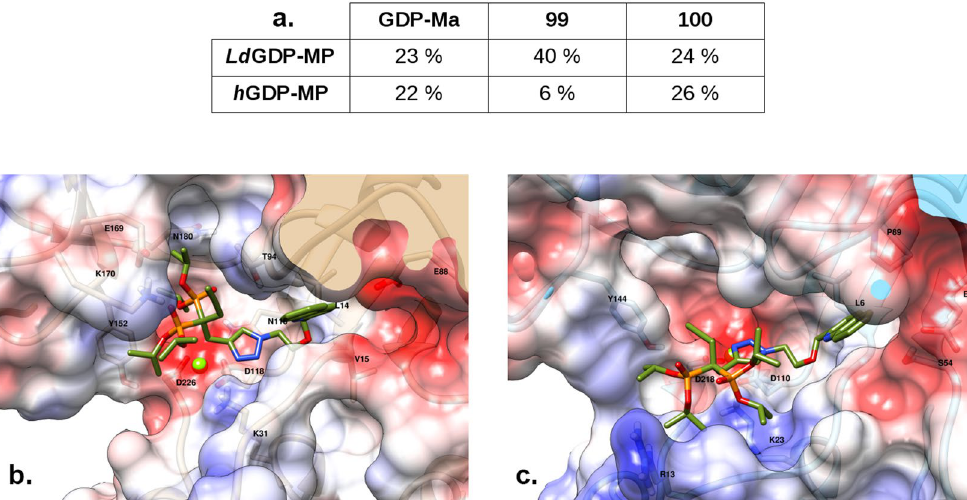
Figure 6. Docking analysis of compounds 99 and 100 on Ld GDP-MP and h GDP-MP. ( a ) Percentage of “good” poses of GDP-Mannose, compound 99 and 100 over the hundred conformations generated by the ten docking calculations onto Ld GDP-MP and h GDP-MP. For GDP-Mannose, a “good” pose is the one observed in the PDB crystallographic structure 2X5Z. For the two compounds 99 and 100 , a “good” pose has the quinoline group located on the GDP-Mannose guanine. ( b,c ) Position and orientation of the lowest energy “good” pose of compound 99 in the catalytic site of Ld GDP-MP ( b ) and hGDP-MP ( c ). The protein surface is colored as a function of the charge density (red, white and blue colors indicating negative, neutral and positive area, respectively). The amino-acids that make contacts with compound 99 are indicated by their one-letter code and number in the